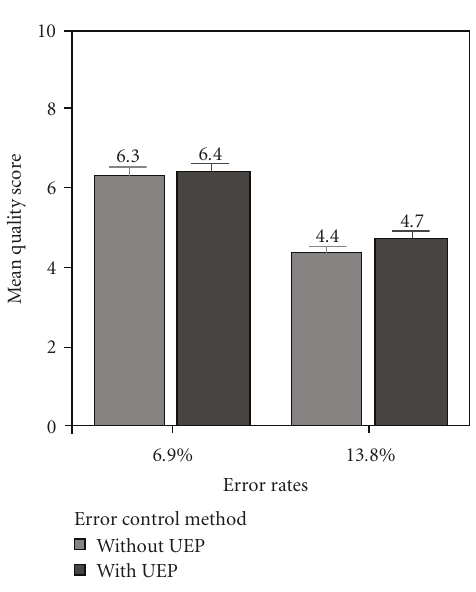
Figure 10: Overall mean satisfaction ratings for UEP scheme. The error bars show 95% CI of